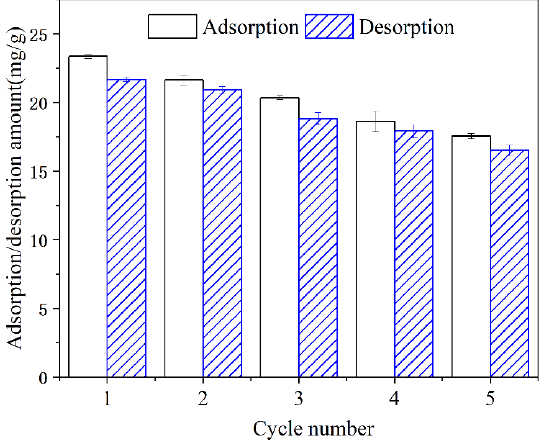
Figure 7. Adsorption and desorption performance in the cycling experiment.